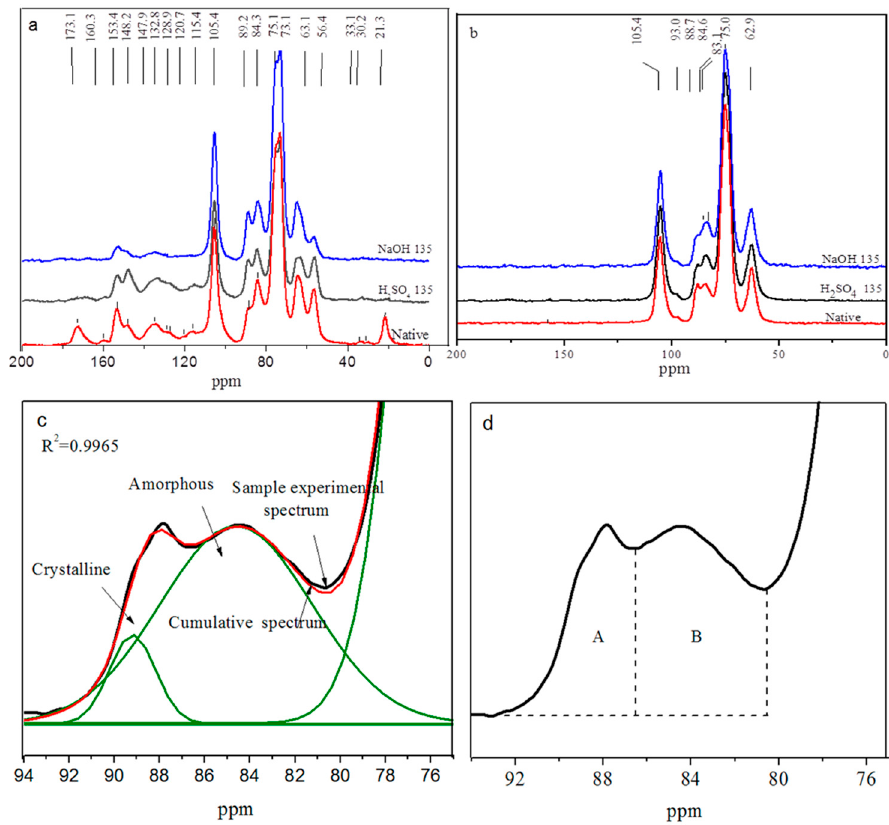
Figure 4. Solid-state cross polarization / magic angle spinning (CP / MAS) 13 C nuclear magnetic resonance (NMR) spectra of solid particle samples (native, SA135, and SH135) ( a ), holocellulose samples for raw bamboo materials and pretreated (naive, SA135, and SH135) ( b ); the fitted curve of the C4 region ( c ), and the crystalline calculation of the C4 region ( d ).